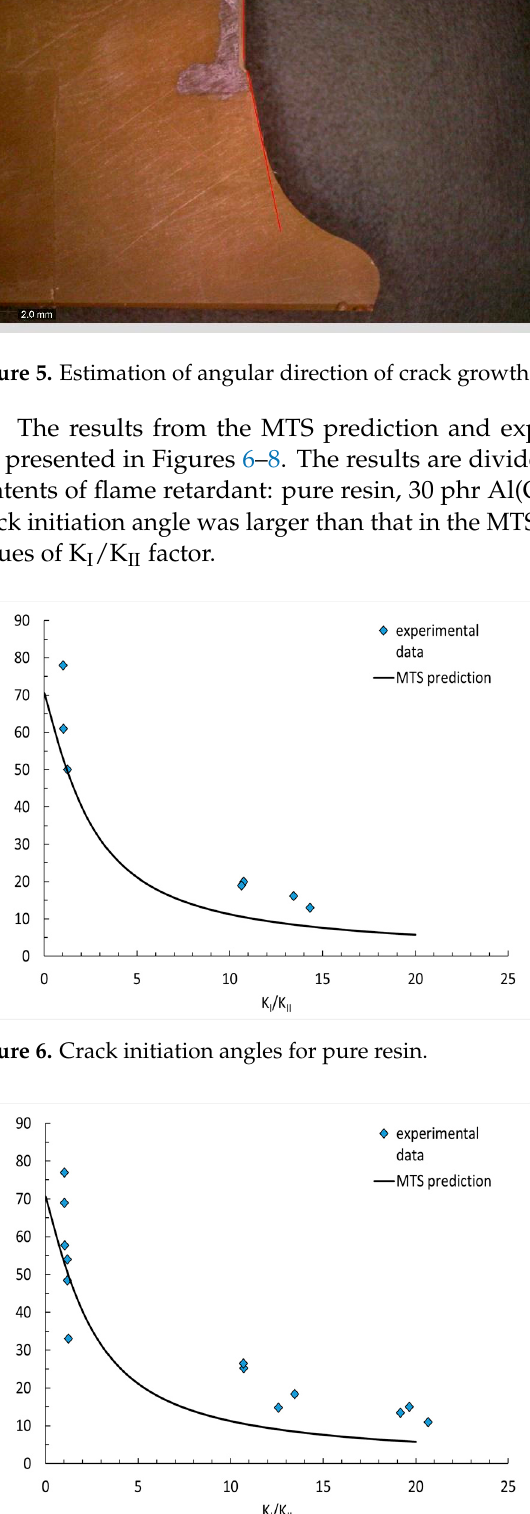
Figure 8. Crack initiation angles for 50phr Al(OH) 3. The applied MTS prediction for the fracture toughness ratio did not reflect the correct values, specifically for smaller angels. Basically, the experimental data (blue points) was ordered in a similar manner as the predicted curve, which may suggest that some correction factor for the MTS prediction might be useful and increase the accuracy. As a result of these tests, the influence of filler addition on the values of the fracture toughness coefficient K I and K II were determined. The outcomes are presented in Figures 9–12, presented as a bar chart grouped using the mode I and II ratio. Considering the presented results, it might be indicated that the addition of flame retardant significantly impacted the fracture toughness properties, decreasing the values by roughly 50%. Additionally, it is noticeable that the differences between the flame retardant contents did not cause notable changes in the results. This suggests that basically the fracture behavior of the epoxy resin was affected by the fillers decreasing the cohesive force, independently of the volume content.